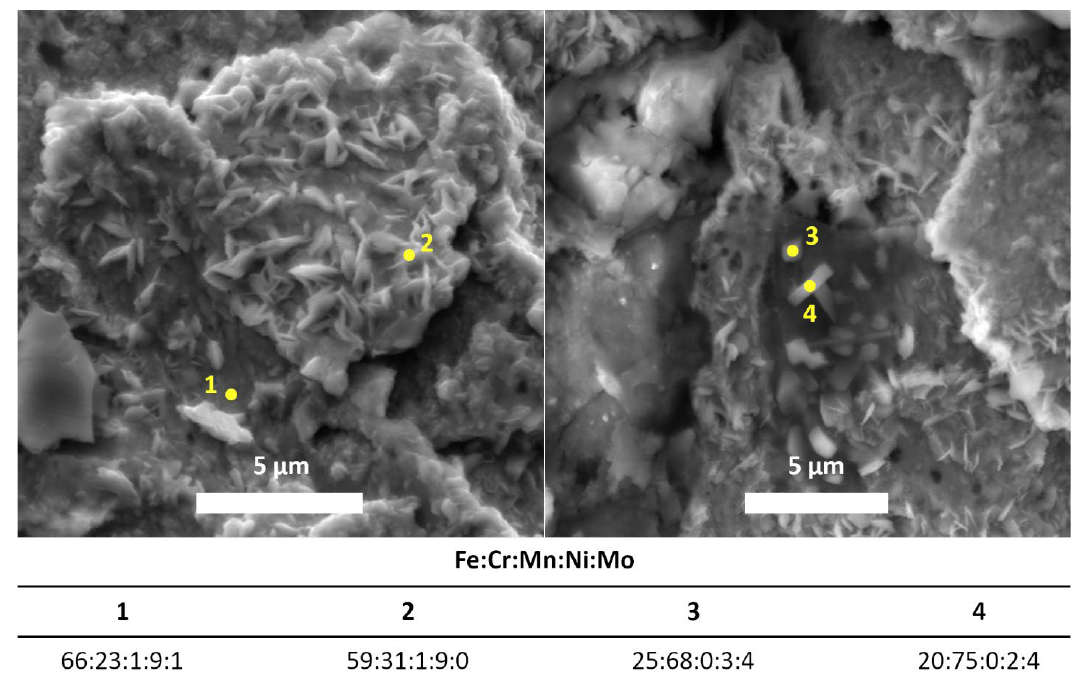
Figure 3. Elemental analysis at selected points of the sample annealed for 32 h at an accelerating voltage of 15 kV. voltage of 15